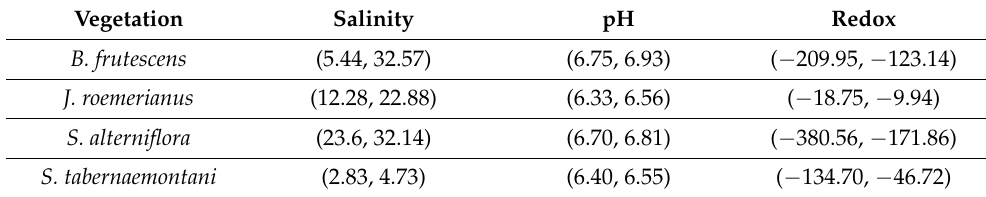
Table 2. Test of 95% confidence interval for salinity, pH, and redox of four species found in salt marshes of coastal Georgia (USA).